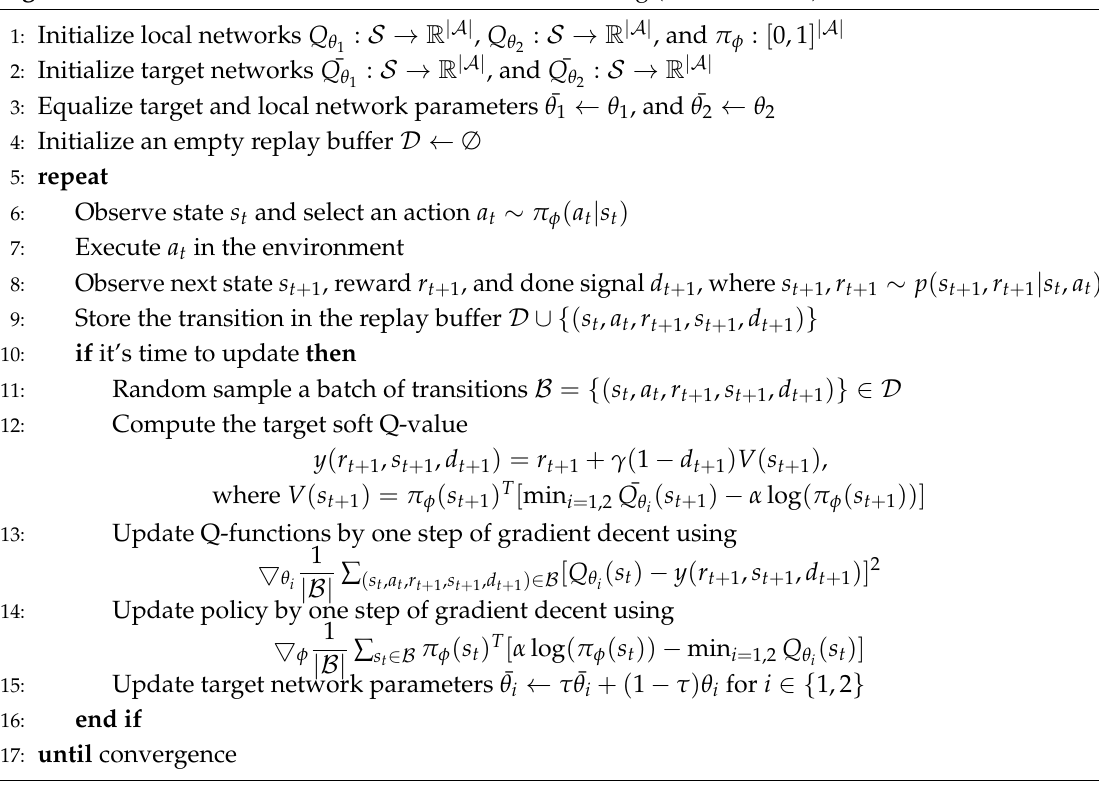
Algorithm 1 Soft Actor–Critic with Discrete Actions Setting (SAC-Discrete).